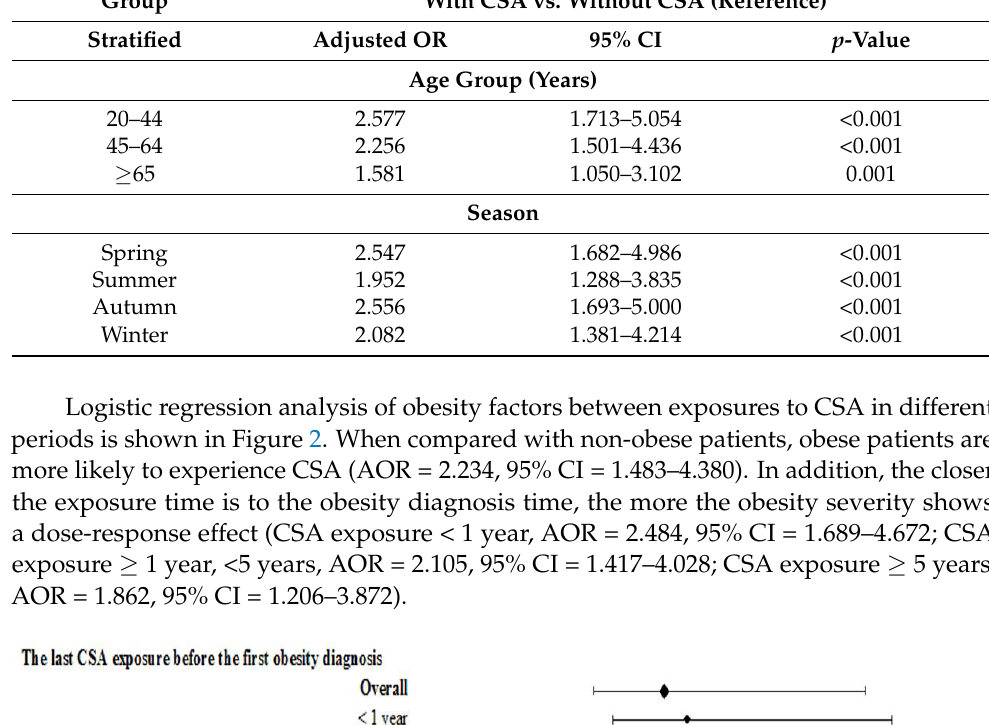
Table 3. Factors of obesity stratified by variables using logistic regression.